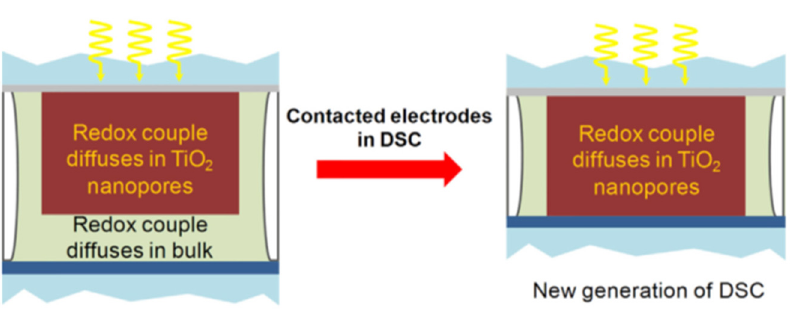
Figure 7. Schematic of the new DSSC architecture employing electron-blocking p-type hole-specific charge collectors in direct contact with the mesoporous TiO 2 scaffold [65].